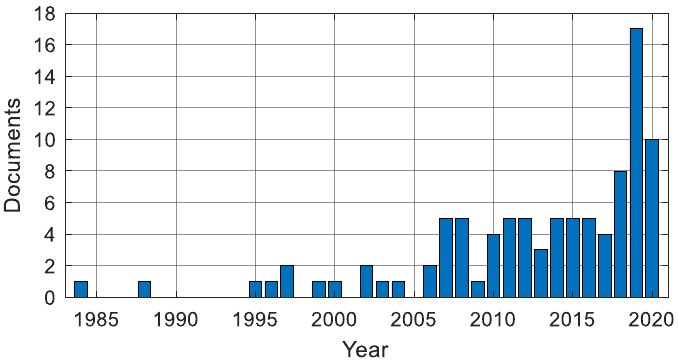
Figure 1. Number of publications dealing with the design, sizing and management of harbor microgrids over the years, according to the Scopus database (results of 15 September 2020).